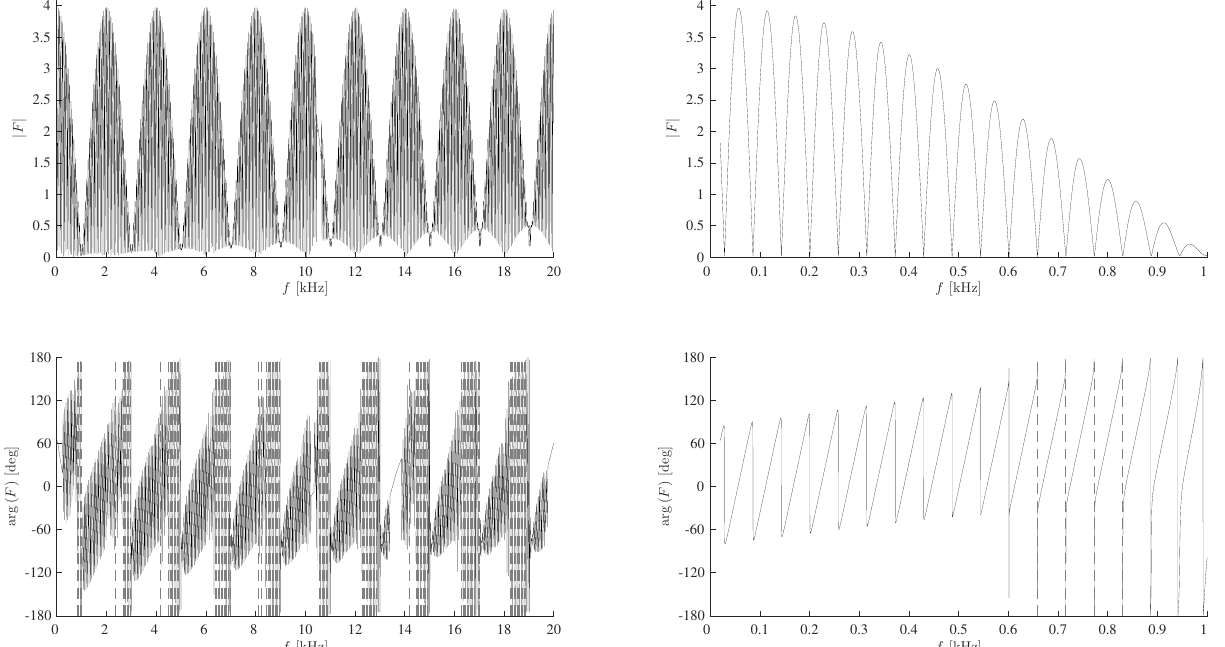
Figure 3: Modulus (top) and phase (bottom) of the multipath factor (18) versus frequency in the audible range (left), 20 ≤ f ≤ 20000Hz , or in the sub-range (right), 20 ≤ f ≤ 1000Hz , for a fixed observer at the position ( a , b ) = (3, 2) m and fixed source at the position ( x , y ) = (700, 30) m , and rigid ground and wall, R